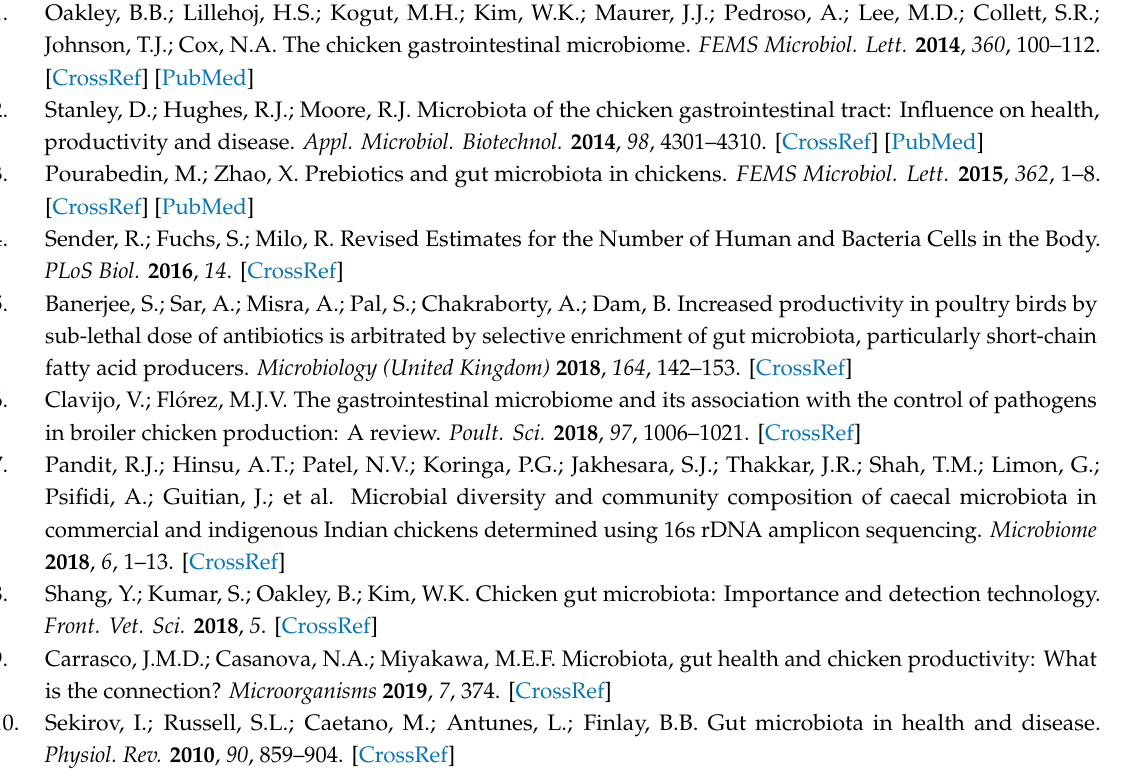
Table S1. Statistical comparison of alpha diversity between sample groups based on Chao 1 index, Table S2. Statistical comparation of alpha diversity between sample groups based on Shannon index, Table S3. Statistical comparation of alpha diversity between sample groups based on Simpson index, Table S4. Statistical comparation of alpha diversity between sample groups based on Observed OTUs index, Table S5. Di ff erent taxonomic profiles at genus level according to the moment of the growing period in fast (FG) and slow-growing (SG) breeds, Table S6. Statistical comparison between beta diversity indexes calculated according to the di ff erent